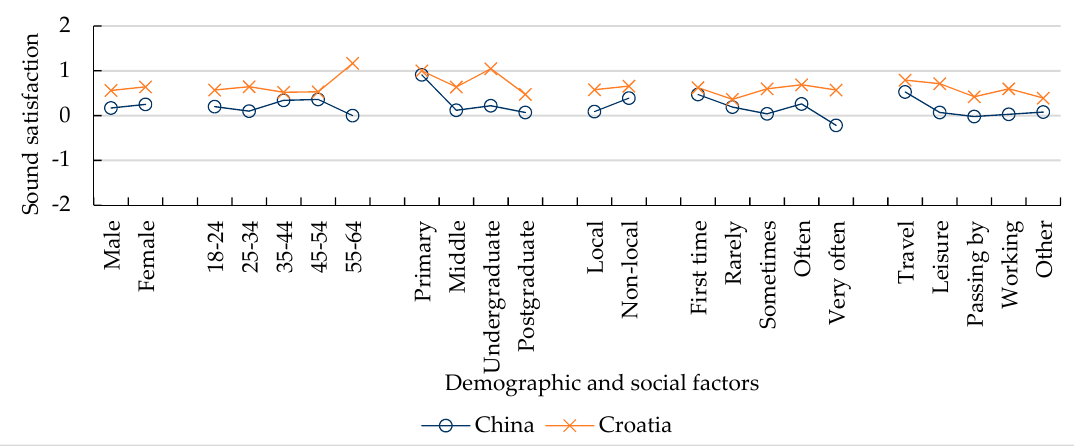
Table 6. Spearman’s rho correlations between subjective satisfaction, tranquility importance as well as soundscape factors, and demographic/social factors of gender, age, education, living place, visit frequency and visit purpose. Sound satisfaction